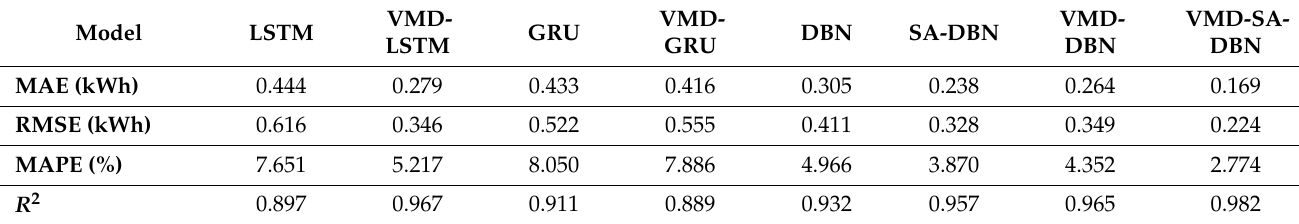
Table 3. Basic statistics of energy consumption